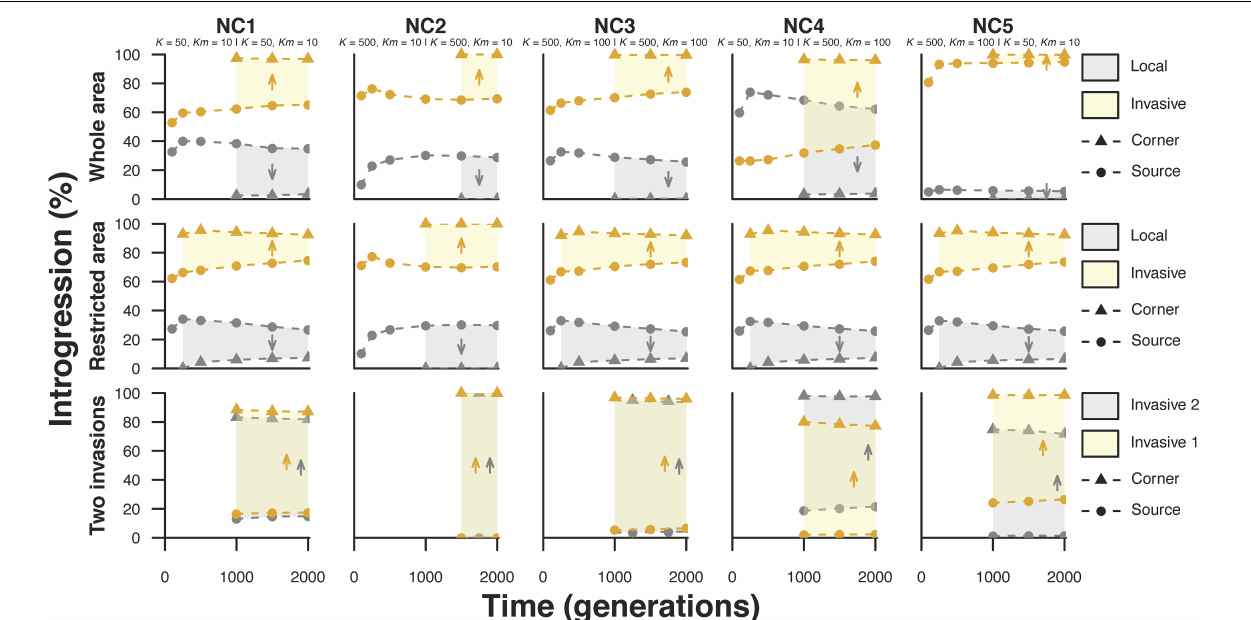
FIGURE 4 | Effect of time since the onset of biological invasion on the level of introgression. Two interacting taxa are represented with different colors (yellow and gray). The level of introgression (%) is estimated in both the source of the expansion and the extreme corner in which both taxa are present. The arrows indicate the direction of the invasive taxon colonization. Three scenarios of biological invasion (see Figure 1 ) and five demographic sub-scenarios (see Table 1 ) were simulated. The demographic parameters of sub-scenarios for taxon 1 and taxon 2 are also presented (taxon 1 | taxon 2). Taxon 1 is considered to be local under the “whole area” and “restricted area” scenarios but invasive under the “two invasions” scenario. Taxon 2 is always considered to be an invasive taxon. The values of introgression are averaged over 10,000 simulations.